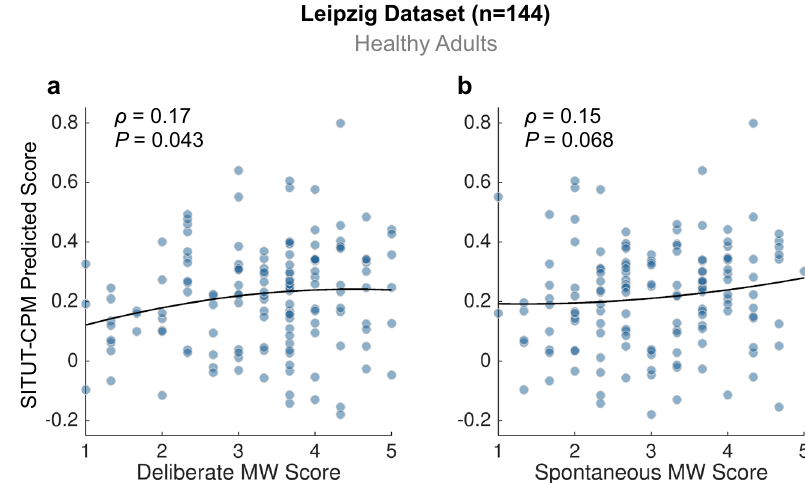
Fig. 5 SITUT-CPM predictions from resting-state fMRI data correlate with individual differences in deliberate and spontaneous mind wandering questionnaire scores (Leipzig dataset). a Signi fi cant positive correlation between SITUT-CPM-predicted versus observed scores on the Mind Wandering Deliberate scale within a dataset collected at the University of Leipzig. b Same as a but for the scores on the Mind Wandering Spontaneous scale. Trend lines (for visualization purposes) are based on locally weighted regression fi tting with a second-order polynomial. For both a and b , statistical testing was performed based on Spearman ’ s rank correlation (coef fi cients and two-sided p value shown without correction for multiple comparisons). SITUT stimulus-